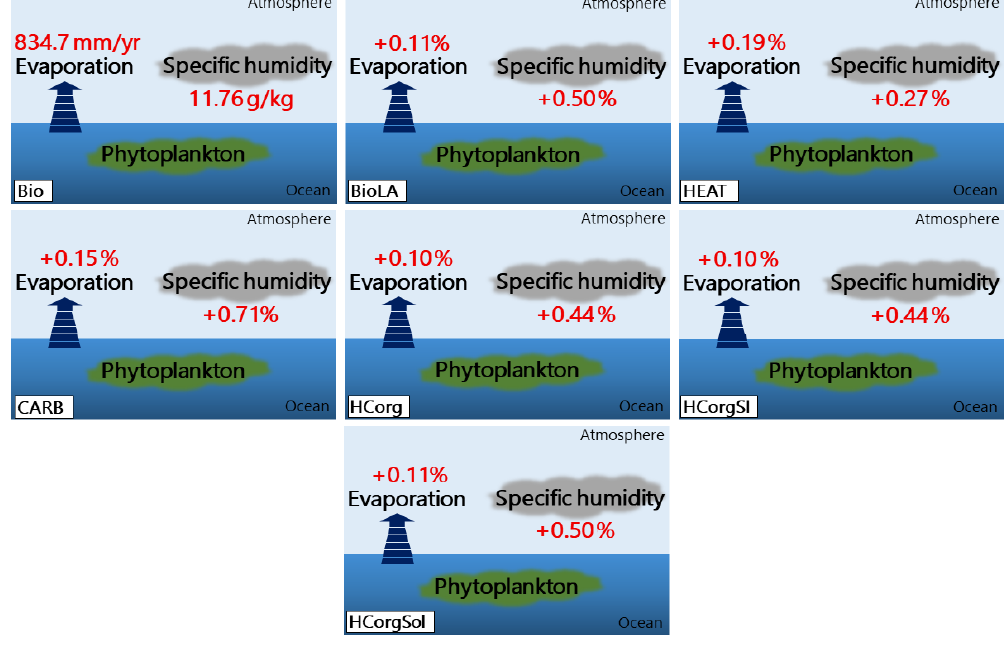
Figure 6. Evaporation (mmyr − 1 ) and specific humidity (gkg − 1 ) for the seven simulations. The percentages represent the relative changes compared to Bio. The name of the simulations are on the bottom left of each panel.